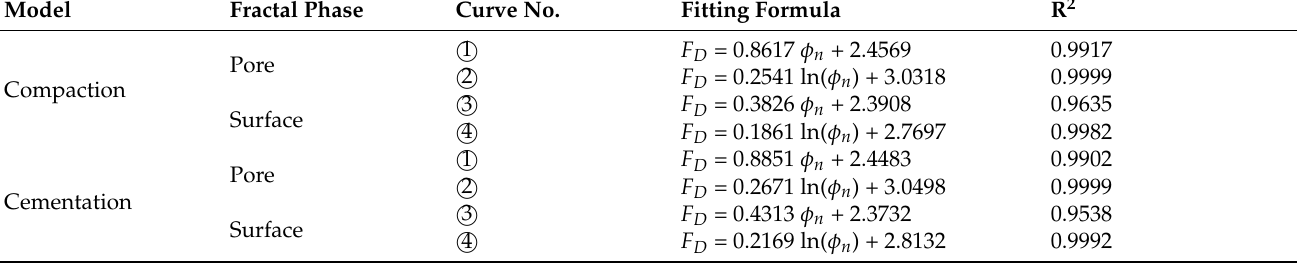
Figure 9. Fitting curves of F D versus φ n in ( a ) compaction model and ( b ) cementation model. Table 3. Fitting equations of fractal dimensions.